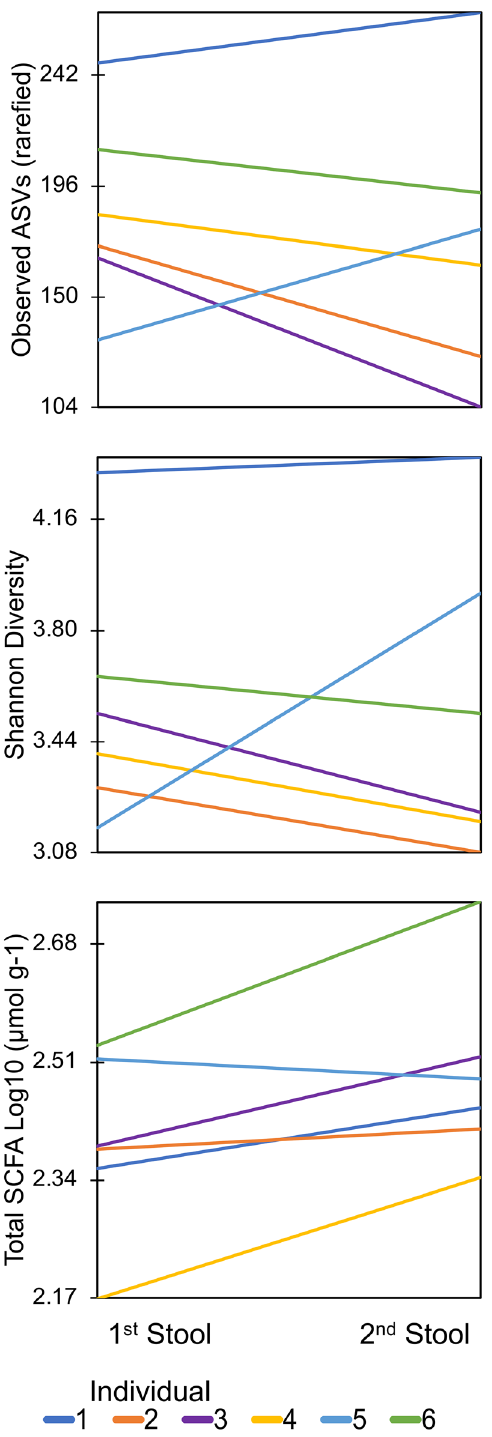
Figure 6. Bacteriome diversity estimates and short chain fatty acid concentration for two consecutive stool collections. Time between stool collections was 8, 2, 4, 10, 4, and 25 h rounded to the nearest whole hour for individuals 1–6